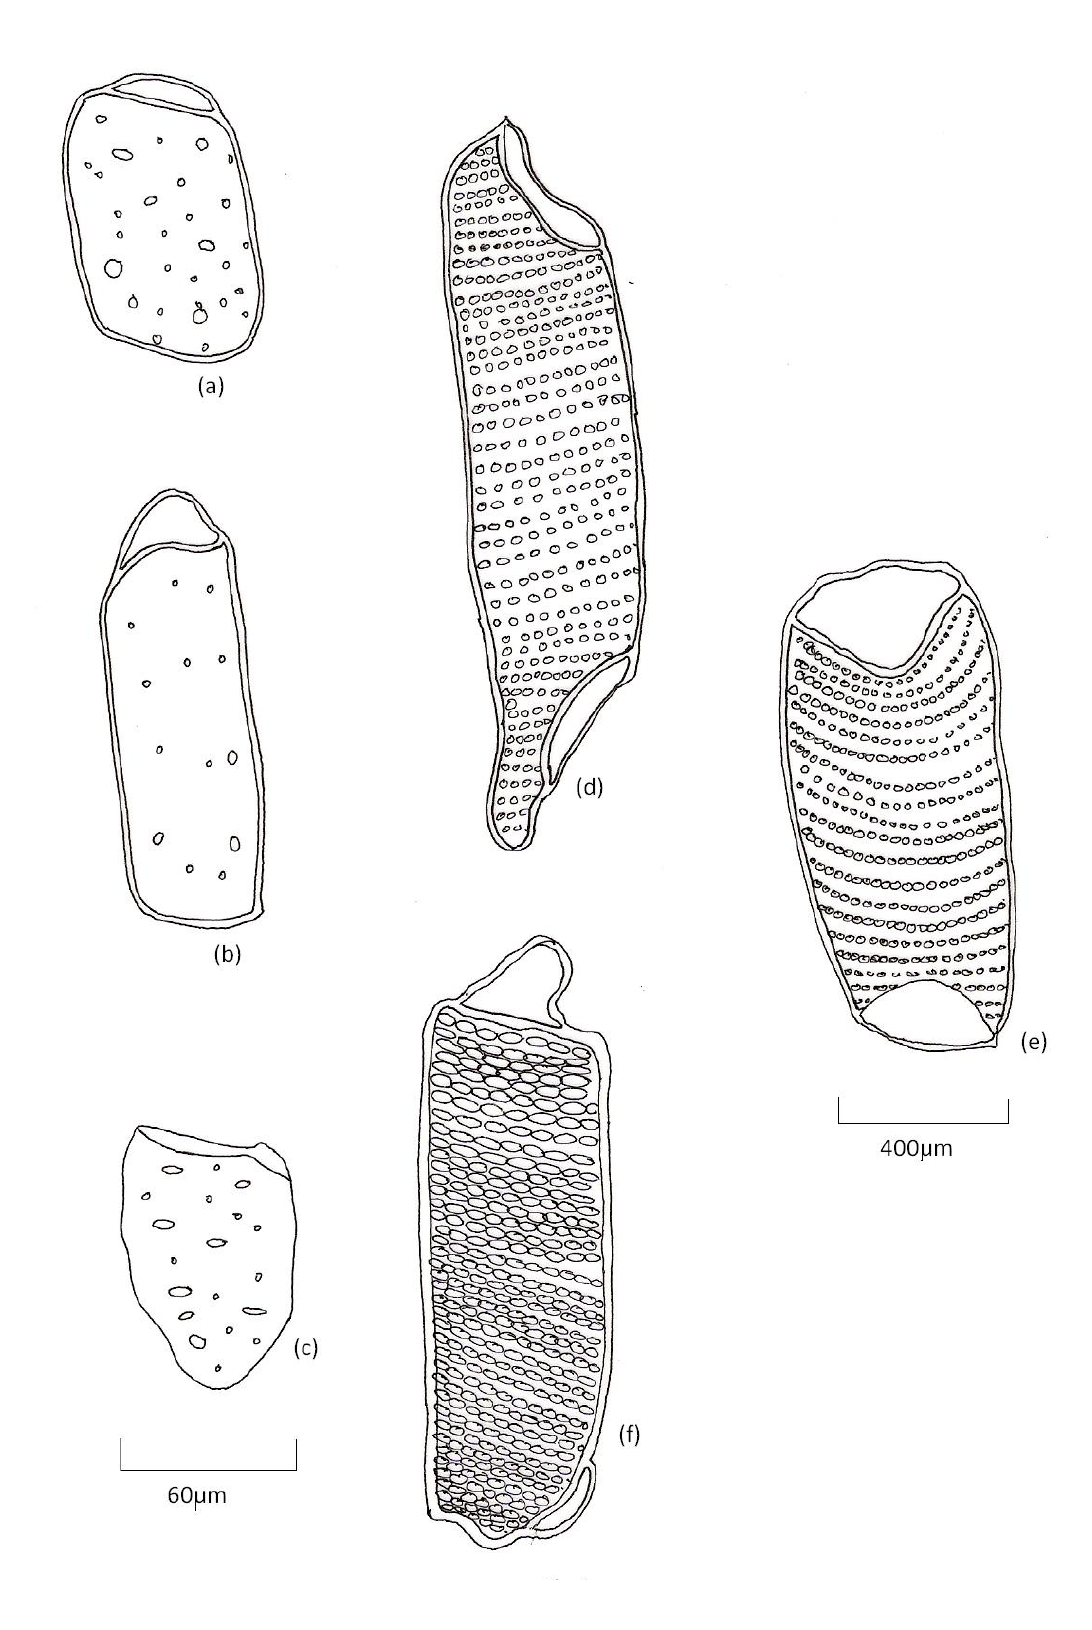
Fig. 4. Diagrammatic illustration of vessel member types of Annona muricata ; Diagram a-c: Wide vessel types in Annona muricata; Diagram d-f: Narrow vessel types in Annona